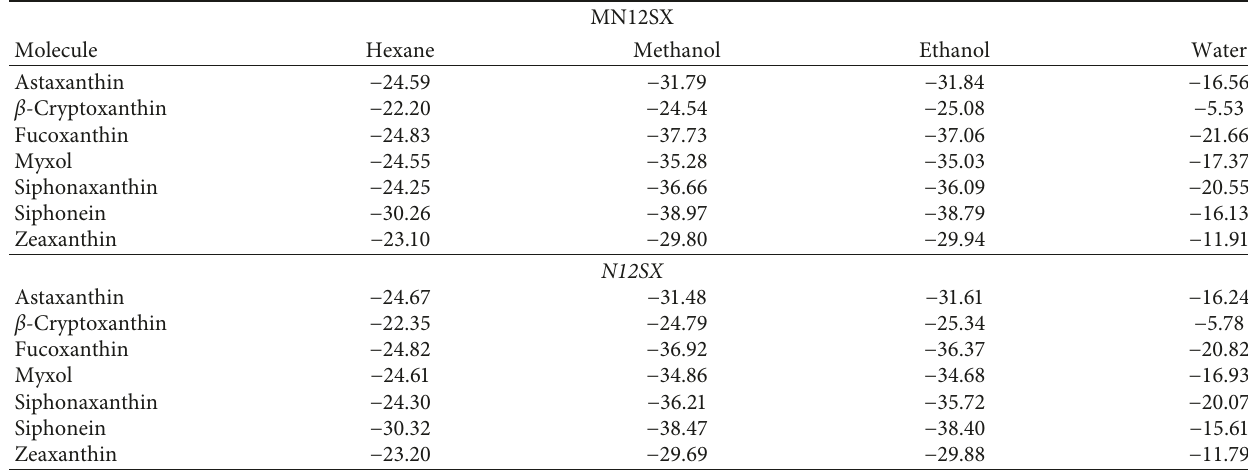
Table 5: Free energy of solvation of the carotenoids (in Kcal/mol) calculated with the MN12SX and N12SX density functionals and the Def2TZVP basis set using hexane, methanol, ethanol, and water as the solvents, simulated with the SMD parametrization of the IEF-PCM